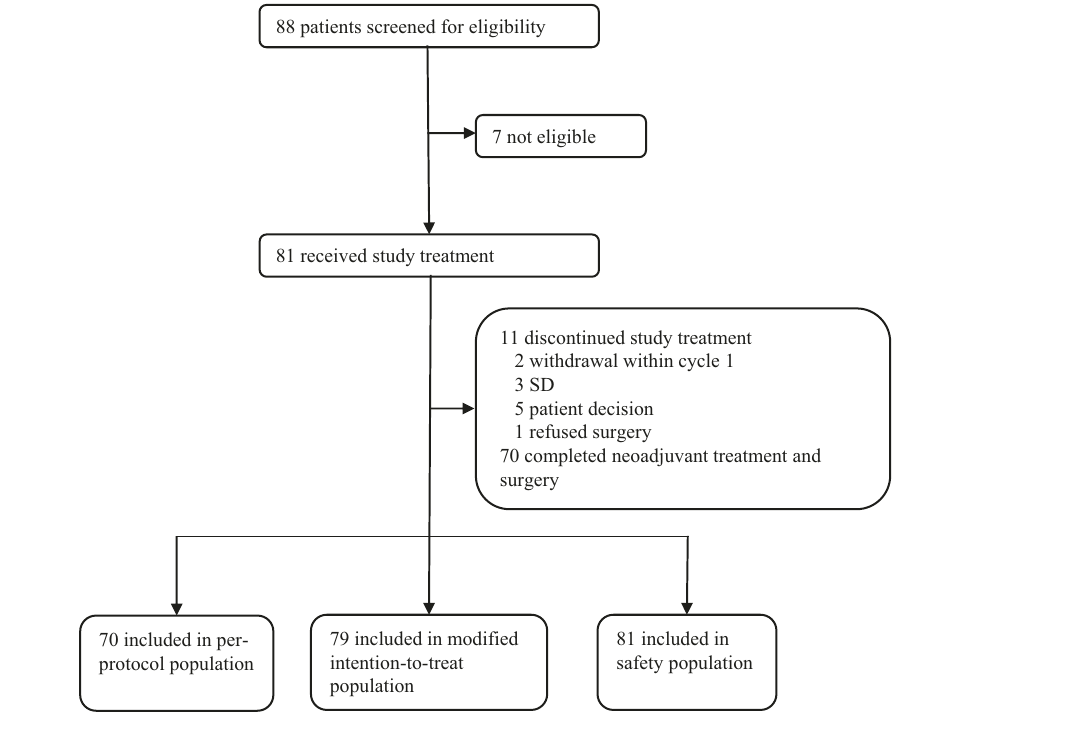
Fig. 1 | Trial pro fi le. Treatment summary and data collection of study